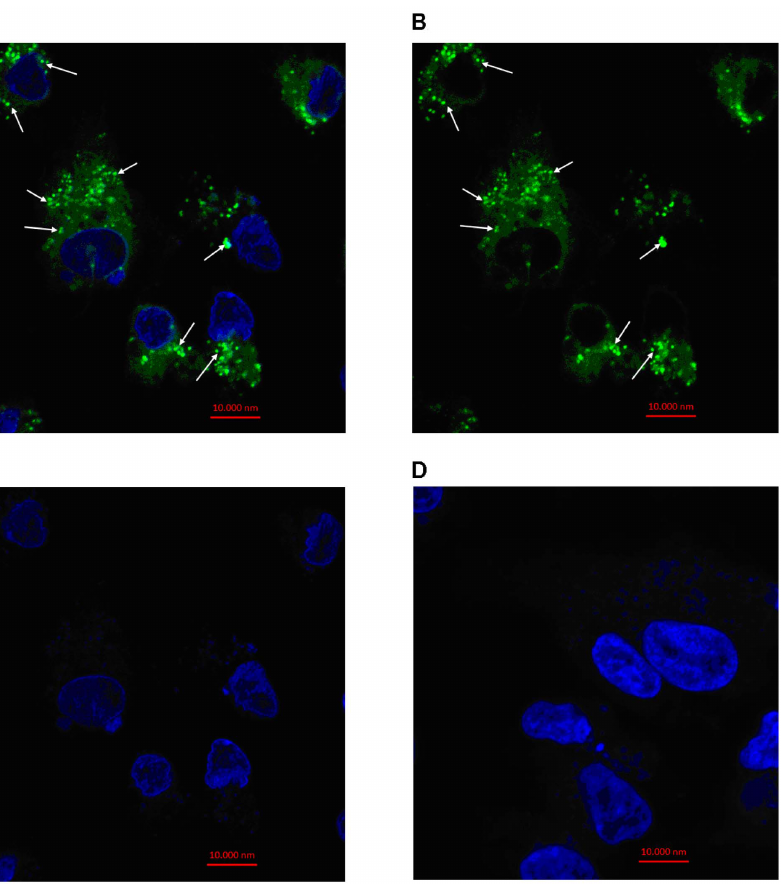
Figure 6. Uptake of PKH67-labeled exosomes by bovine granulosa cells invitro . Exosomes, purified from follicular fluid, were labeled with PKH67 dye and added to primary culture of granulosa cells. Granulosa cells were co-cultured with labeled exosomes isolated from follicular fluid in exosome-free medium for 22 hours under optimum cell culture conditions (37 u C & 5% CO 2 ). Nuclei are stained blue (DAPI) while PKH67-labeled exosomes are stained green ( Figures 7 A, B & C ). Arrows indicate exosomes that were taken up by granulosa cells. Granulosa cells cultured in exosomes free medium containing PKH67-labeled sterile PBS served as a negative control ( Figure 7 D ). Scale bar: 10,000 nm.